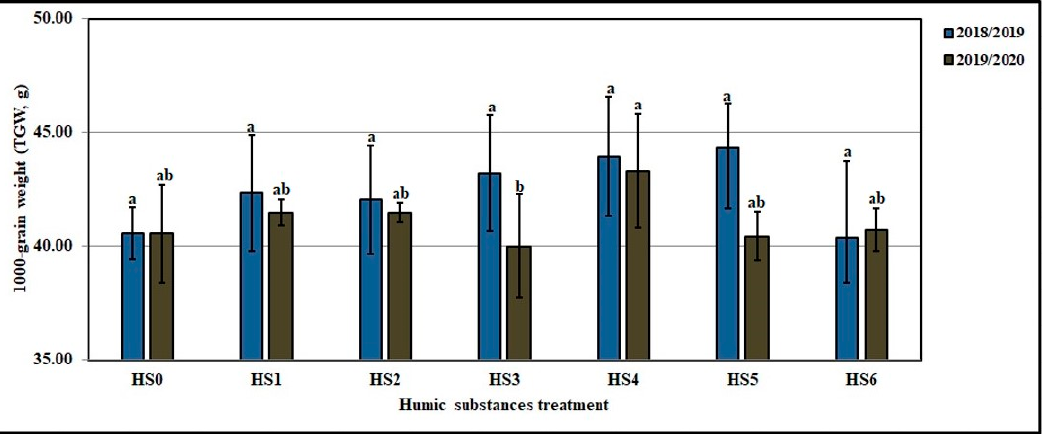
Table 6. Influence of the interaction between humic substances and varieties on spike length, grain